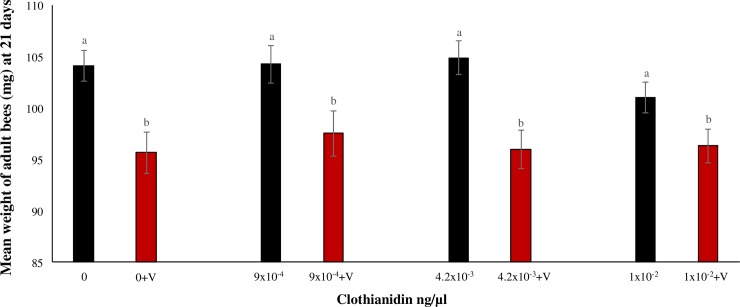
Weight of 21-day old bees after exposure to clothianidin and/or V. destructor.Mean weight (mg ±S.E.) of adult bees exposed to field realistic doses of clothianidin and/or V. destructor (V) for 21 consecutive days. Bars with different letters above them represent significant differences using the Tukey’s HSD test after a two-way ANOVA showed significant differences. Non-transformed data are presented.